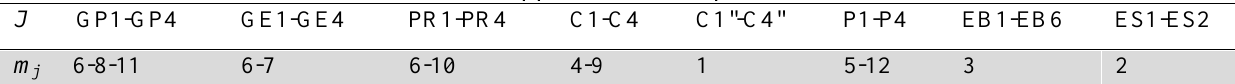
Tool-hole combinations considered in the application example. J